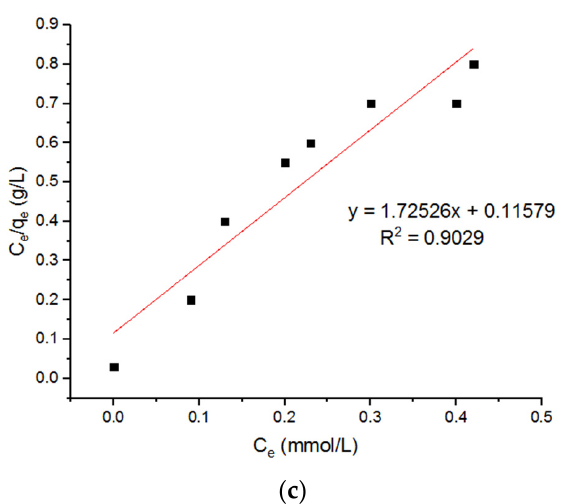
Figure 13. Langmuir plots for adsorption of Cu 2+ ions onto MgFe 2 O 4 -NH 2 nanoparticles pre-functionalization-calcined at ( a ) 500 °C, ( b ) 600 °C, and ( c ) 700 °C.